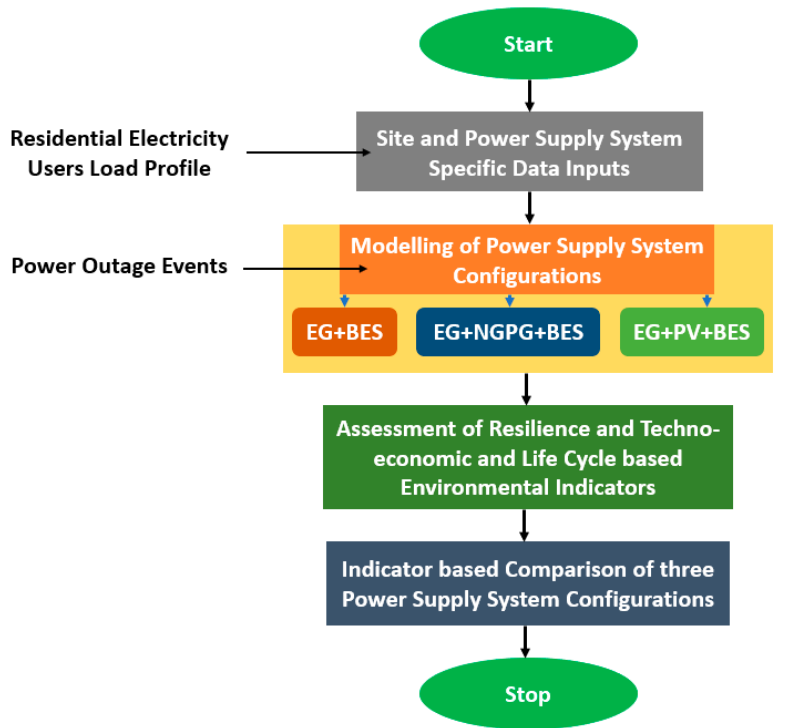
Figure 10. Flowchart for simulation modeling of power supply system configurations. [Notes: EG- Flowchart for simulation modeling of power supply system Electric grid; BES-Battery energy storage; NGPG—Natural gas power generator; PV—Photovoltaics.].